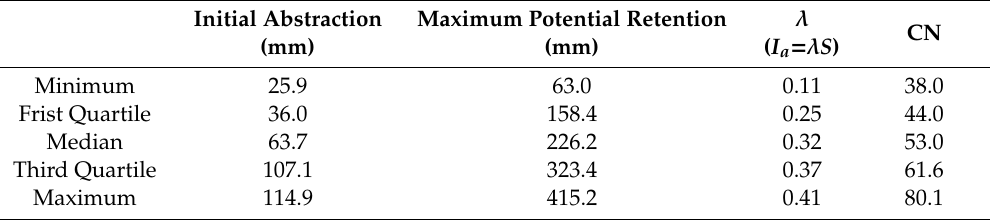
Table 4. Quartiles of initial abstraction, maximum potential retention, and